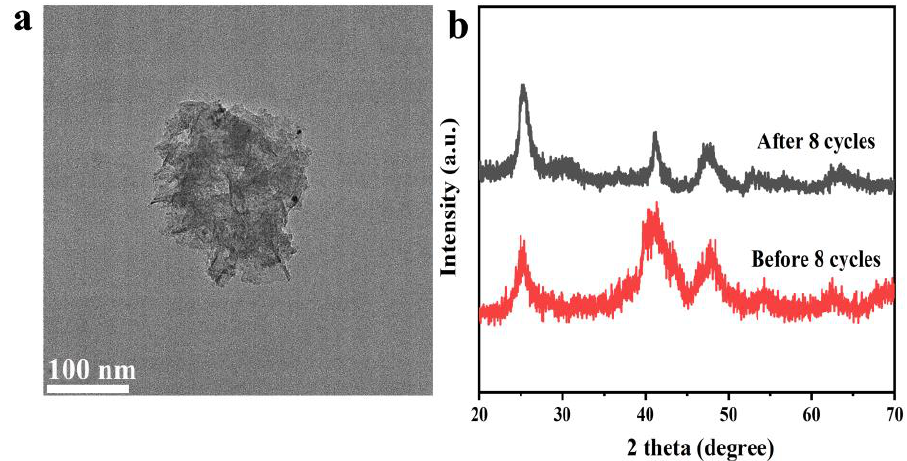
Figure 9. ( a ) Reusability of PtNi/PTOC with 0.1 g catalyst and 1.5 wt% NaBH 4 + 5 wt% NaOH solution at 25 °C; ( b ) HG rate bar chart of catalyst used 8 times.